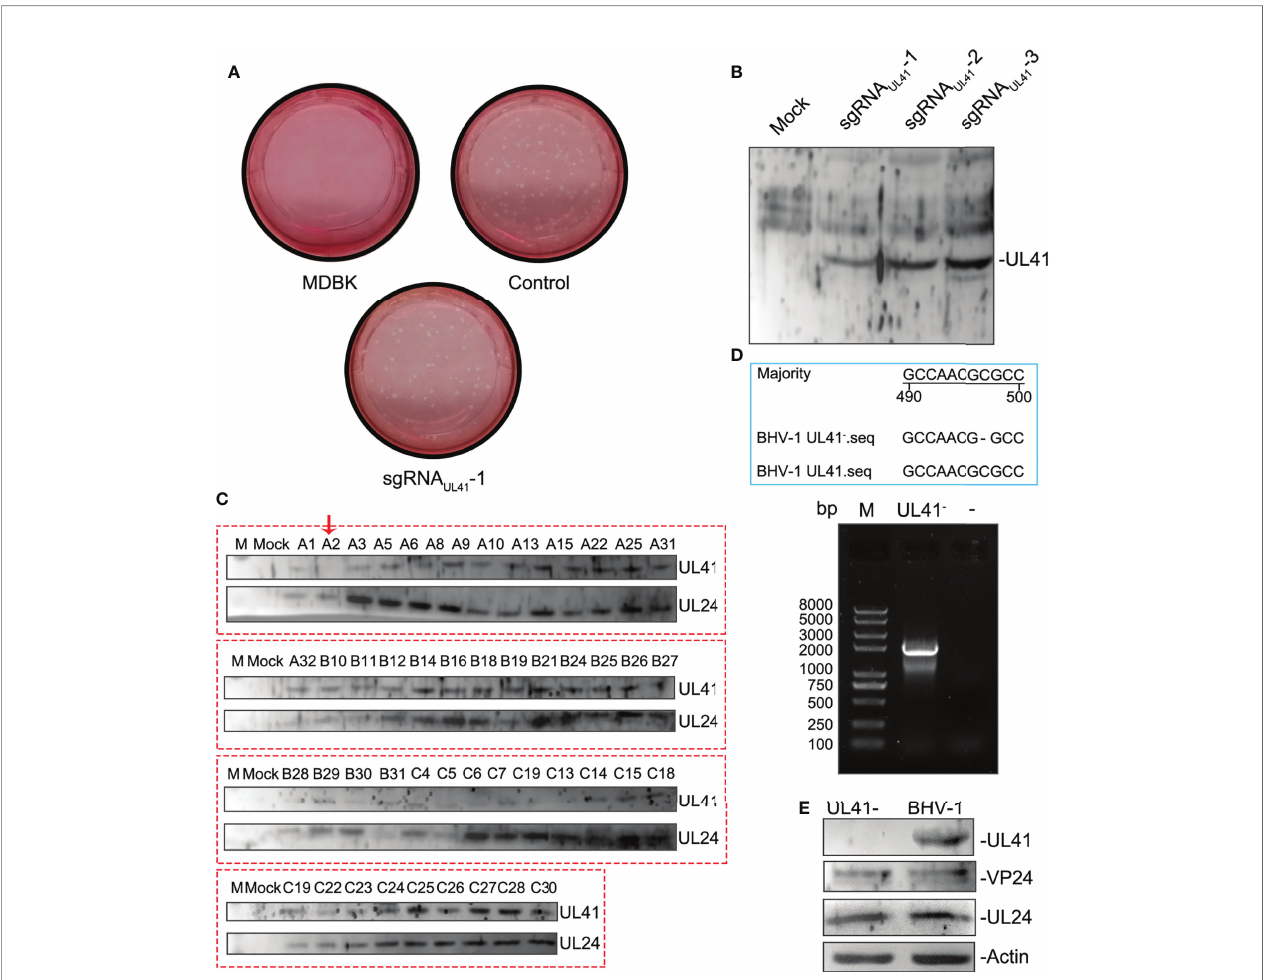
FIGURE 3 | Effective sgRNA screening and identi fi cation of BHV-1 UL41 − . (A) sgRNA UL41 -1 inhibited BHV-1 plaque formation. BL cells were transfected with 4 m g of sgRNA UL41 -1, sgRNA UL41 -2, or sgRNA UL41 -3. Twelve hours later, the cells were infected with BHV-1 (MOI=0.01), and the supernatants were subjected to a plaque formation assay after 48 h of infection. “ Control ” indicates the supernatants edited by the plasmids sgRNA UL41 -2 and sgRNA UL41 -3 for the plaque formation assay. The plaque numbers were calculated in three independent assays, ** for p < 0.01. (B) sgRNA UL41 -1 inhibited BHV-1 UL41 expression. The cell lysates from panel (A) were subjected to Western blotting. UL41 expression was detected with the prepared polyclonal antibodies. “ Mock ” indicates blank BL cells. sgRNA UL41 -1 – 3 indicates the cells infected with the sgRNA-Cas9-edited viruses. (C) BHV-1 UL41 − screening. Plaques from the sgRNA UL41 -1 group were inoculated into 48-well plates. The cell lysates were collected after virus ampli fi cation and analyzed by Western blotting. A2 indicates the UL41-silenced expression virus and is marked with a red arrow. Letters A – C before the numbers indicate the plaques that were ampli fi ed from the three sgRNAs (A for sgRNA UL41 -1, B for sgRNA UL41 -2, and C for sgRNA UL41 -3). BHV-1 UL24 and UL41 were detected with the prepared polyclonal antibodies. UL24 was used as the BHV-1 infection reference control. (D) Cloning and sequencing analysis of the defective viral UL41 gene. Lane M: Trans 2K Plus II DNA ladder. The blue-line-framed area represents the 490- to 500- nucleotide sequencing results of BHV-1 UL41 − ; “ − ” in the BHV-1 UL41 − sequence indicates an absent nucleotide. The “ − ” above the agarose gel chart indicates the water negative control. UL41 − indicates the UL41 gene ampli fi cation of the de fi cient virus. (E) Western blot analysis of the BHV-1 UL41 − strain. “ UL41 − ” indicates the BHV-1 UL41 − strain, and BHV-1 indicates the parent strain. UL41, VP24, and UL24 were detected by the prepared polyclonal antibodies. Actin was used as the internal reference control; UL24 and VP24 were used as the BHV-1 infection reference